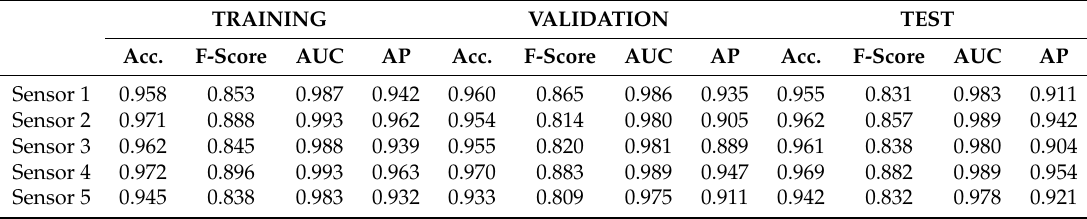
Table 8. The results of second Neural Networks (NN) model for Adam optimizer, learning rate 0.001 and 100